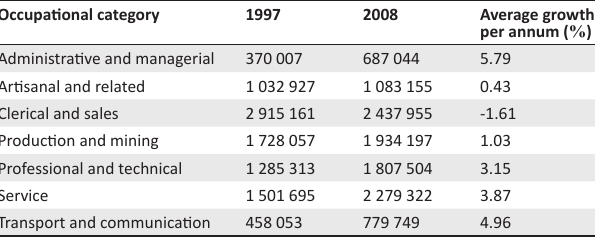
TABLE 1: Growth in selected occupational categories during the 1997–2008